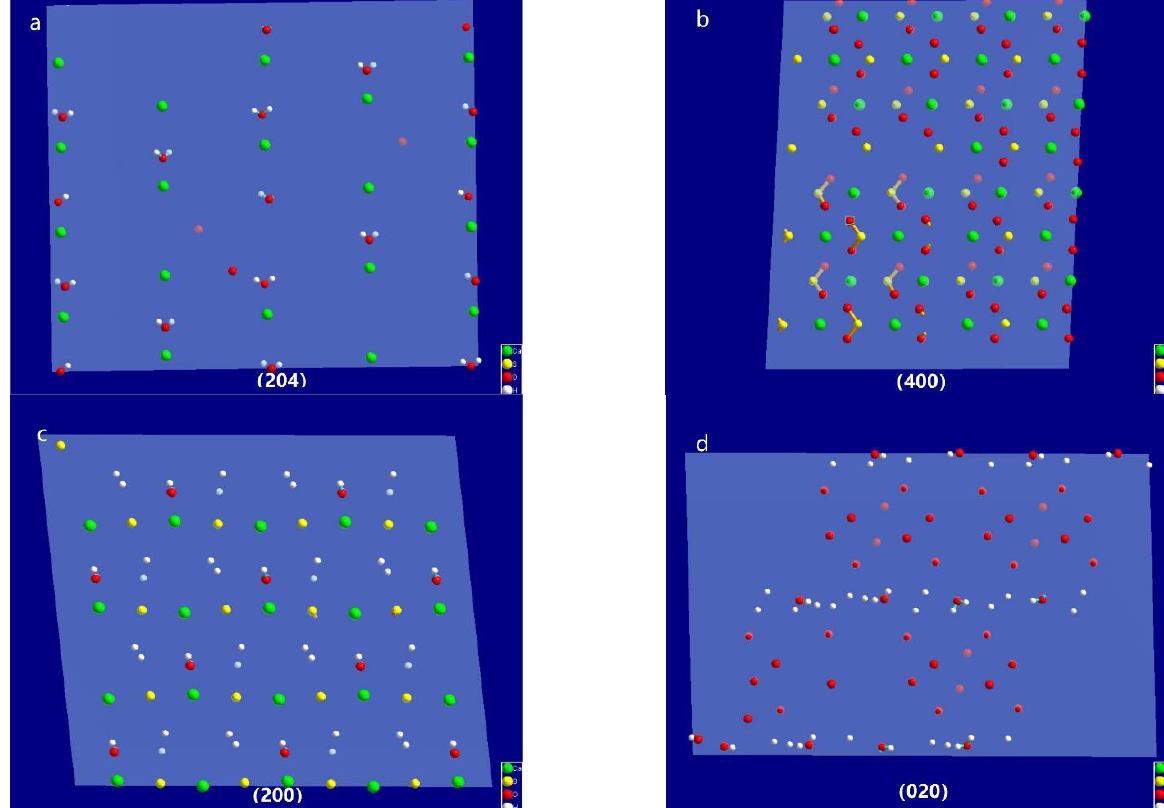
Figure 11. Atoms on the crystal plane of ( a ) (204), ( b ) (400), ( c ) (200) and ( d ) (020).